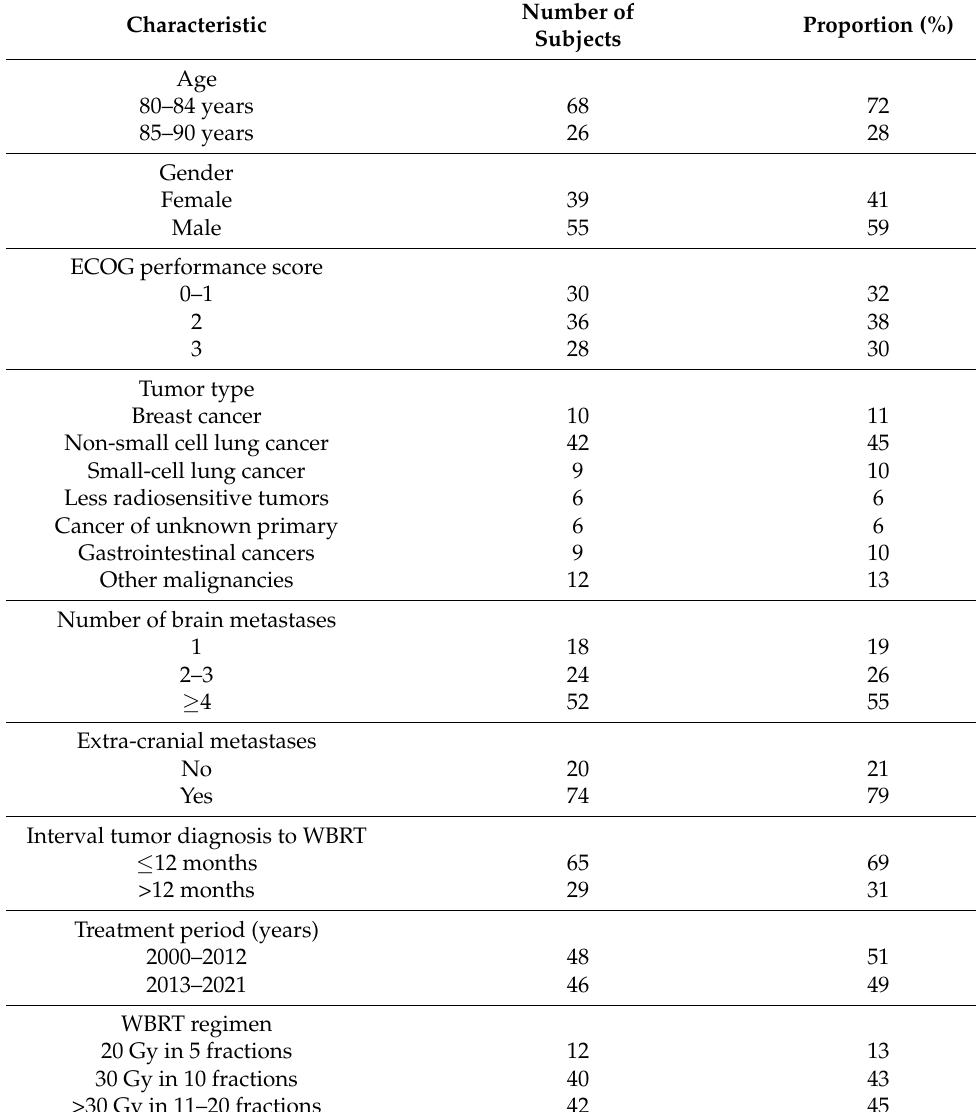
Table 1. Characteristics evaluated for